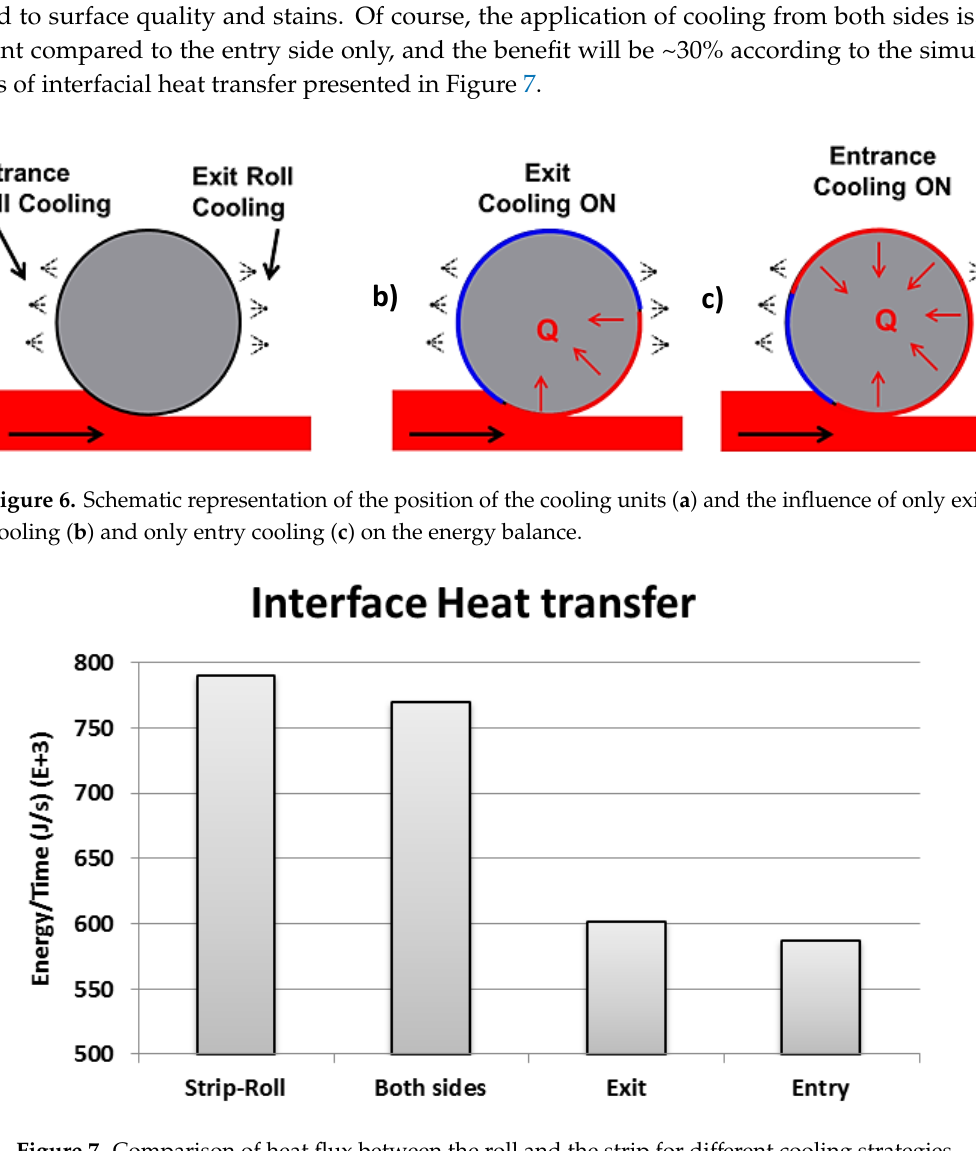
Figure 7. Comparison of heat flux between the roll and the strip for different cooling strategies.